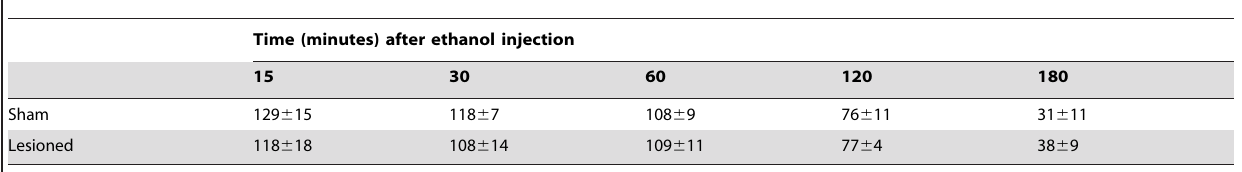
Table 2. BECs (mg/dl) in ethanol naı¨ve sham and lesioned rats following 1 g/kg IP ethanol injection.